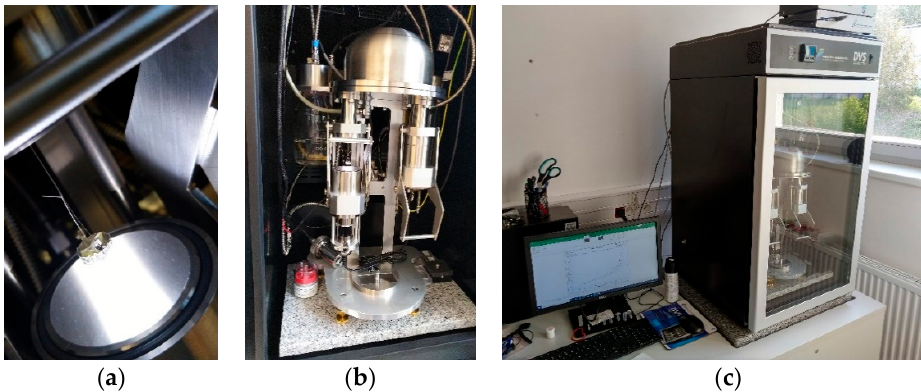
Figure 3. ( a ) Sample pan with a sample in the chamber; ( b ) detail of dynamic vapor sorption (DVS) manifold; ( c ) DVS device with computer.